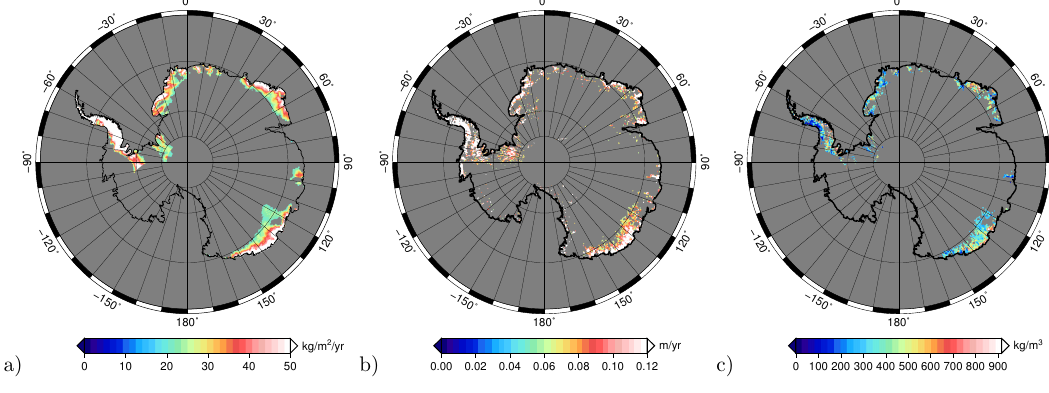
Fig. 7. (a) (GRACE − SMB) > 20kgm − 2 yr − 1 , (b) (ICESat − FDM) > 6cmyr − 1 , (c) derived density (mean 381kgm − 3